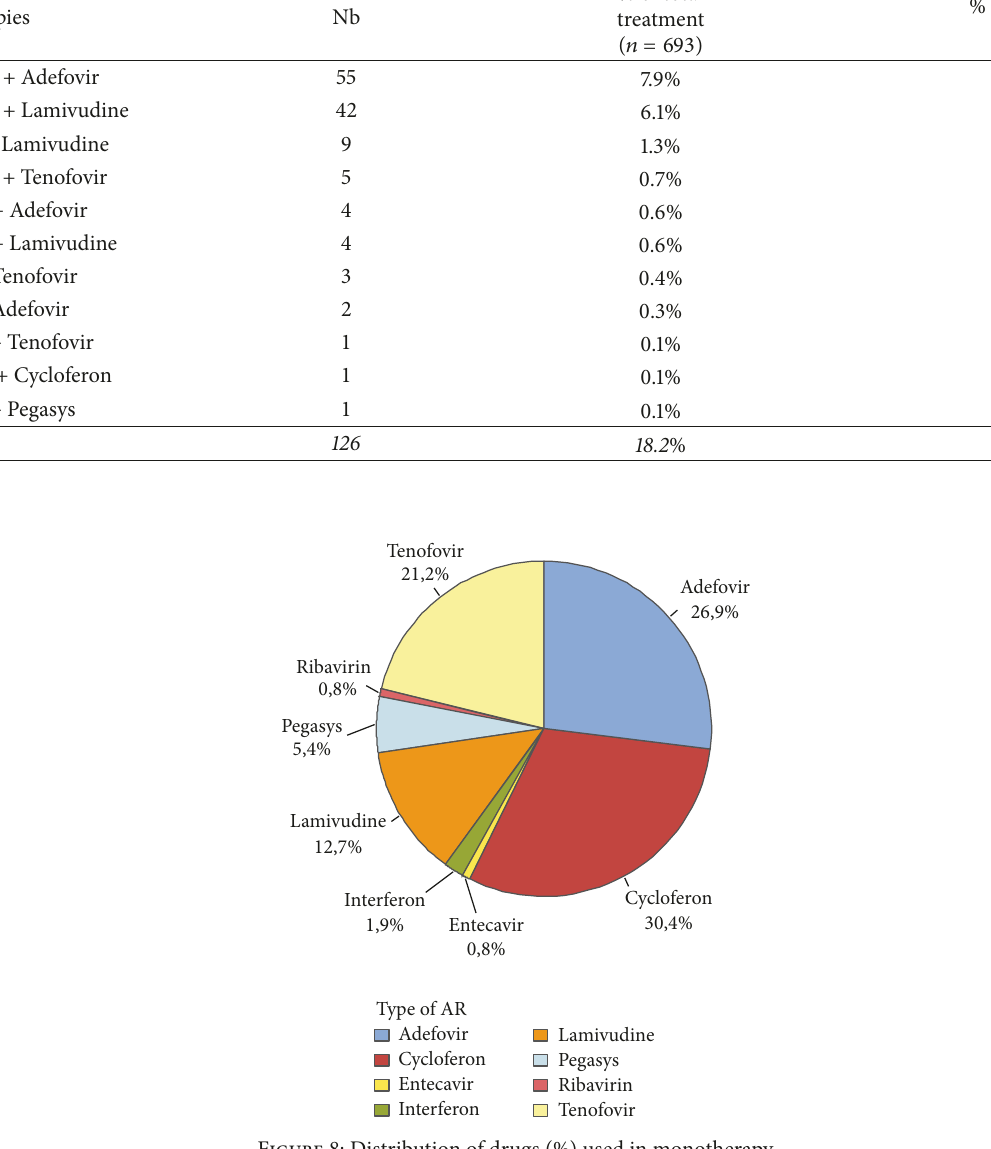
Figure 8: Distribution of drugs (%) used in